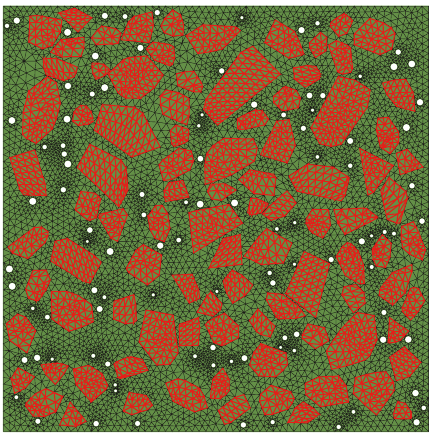
Figure 2: FE mesh discretization (polygonal aggregate).